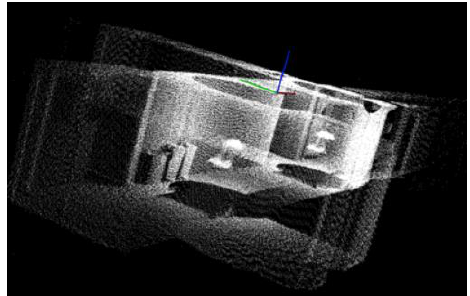
Figure 16. Laser truth reference map using Riegl